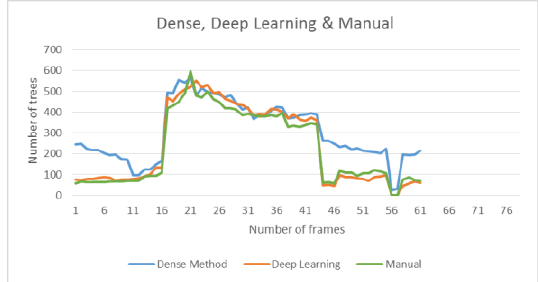
Figure 22 A Comparative Graph Between Dense Count, Deep Learning Count and Manual Count Figure 22 shows line graph comparison of deep learning, dense count and manual count. From the graph the conclusion can be made that deep learning count is close to dense count and manual count in the dense